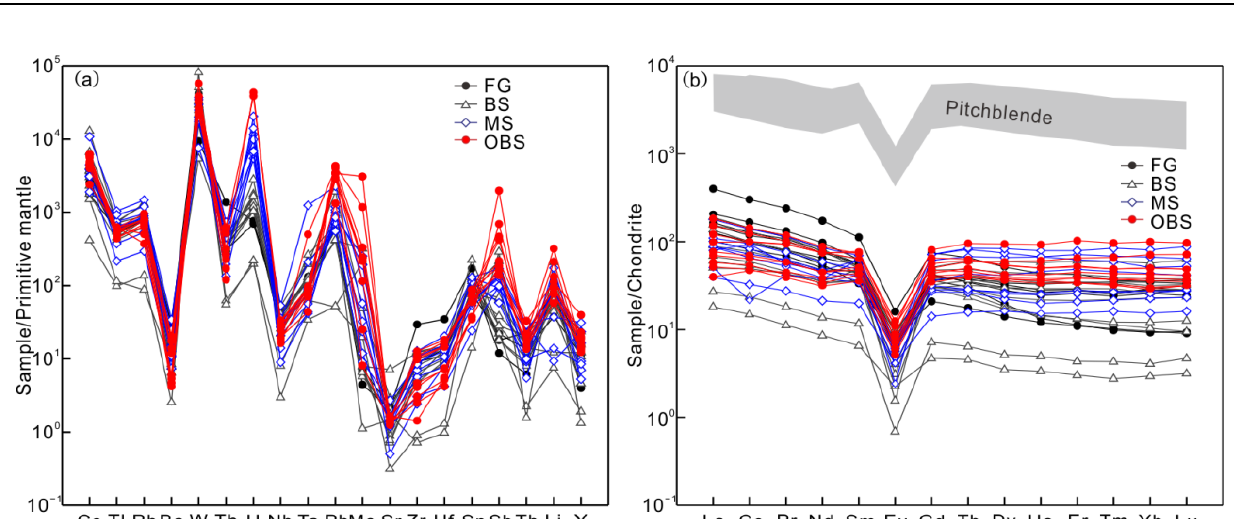
Figure 4. ( a ) Primitive-mantle-normalized trace element spider diagram and ( b ) chondrite- normalized REE diagram for the SJOF granite samples with different U contents. Note: The normalization values are from Sun and McDonough [31], and the pitchblende data are from Chen et al. [4].